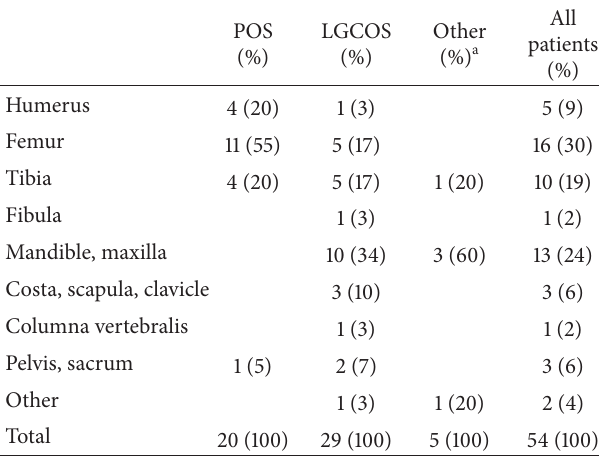
Table 2: Anatomical distribution of 54 patients with low-grade or dedifferentiated osteosarcoma (OS) combined. Separated between parosteal OS (POS), low-grade central OS (LGCOS), and other sub-